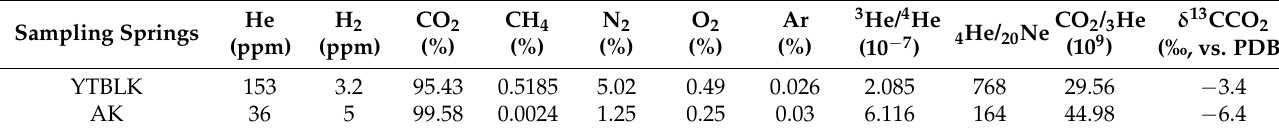
Table 2. Gas composition of the samples in the hot spring